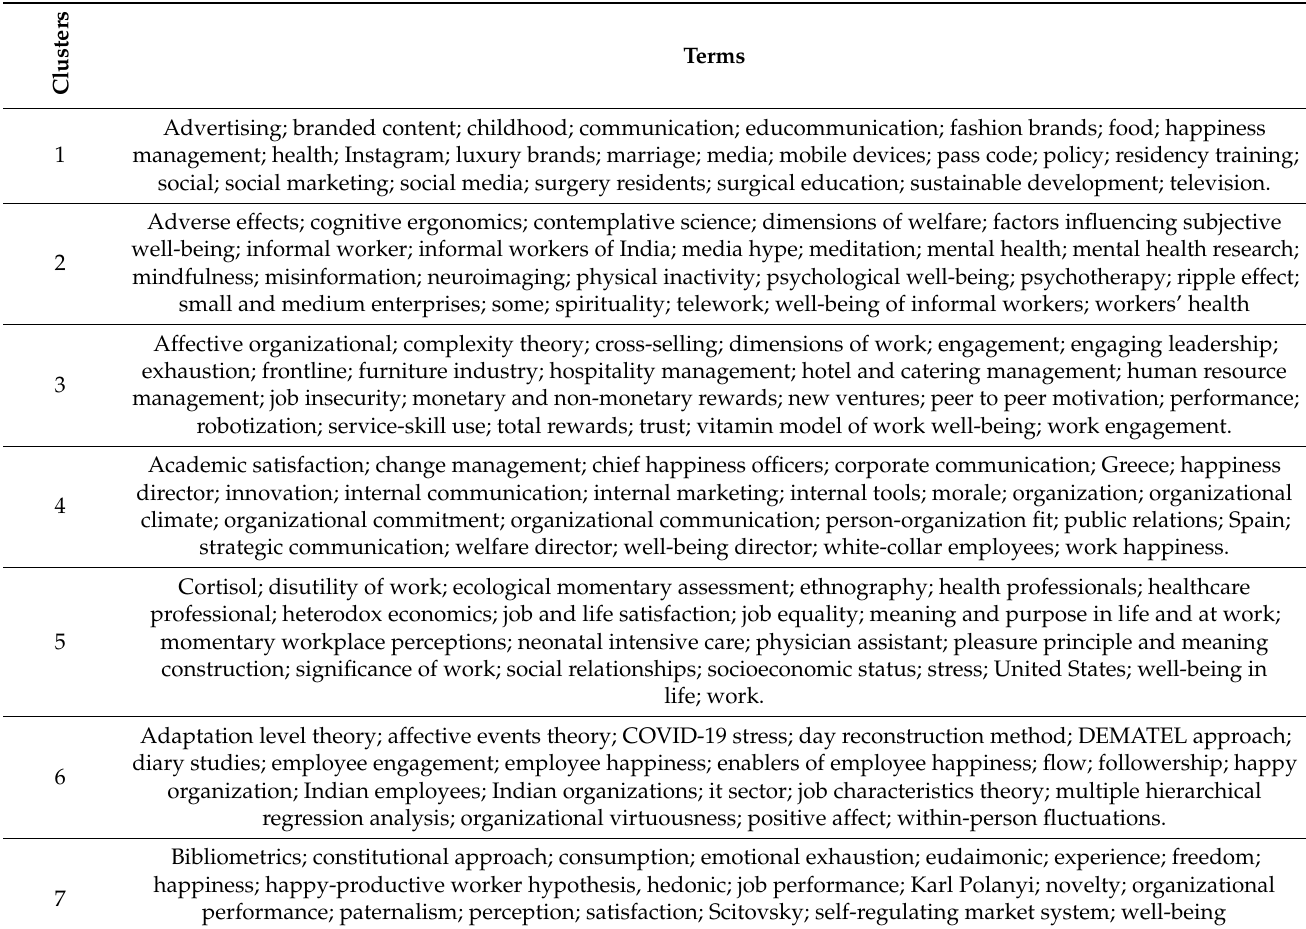
Table A1. Co-occurrence clusters of authors’